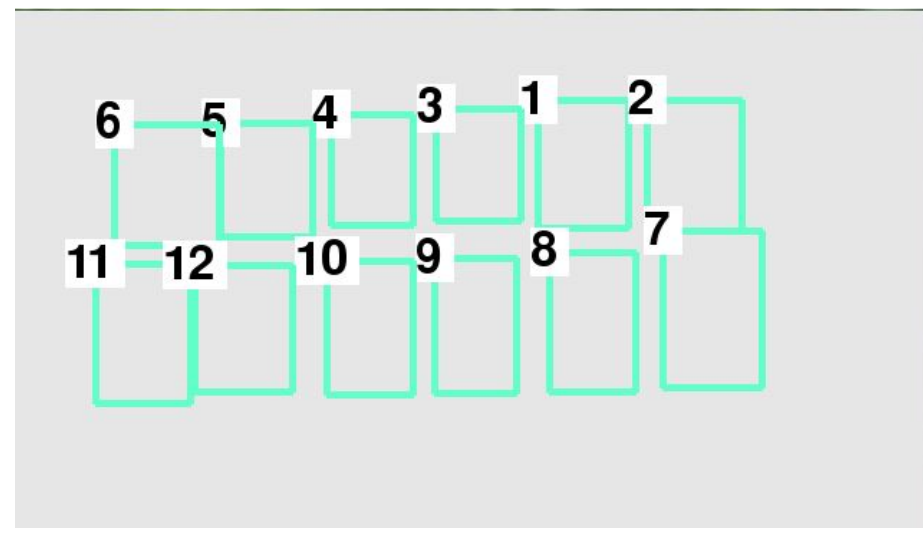
Figure 17. Parking space numbering by the Timsort algorithm.